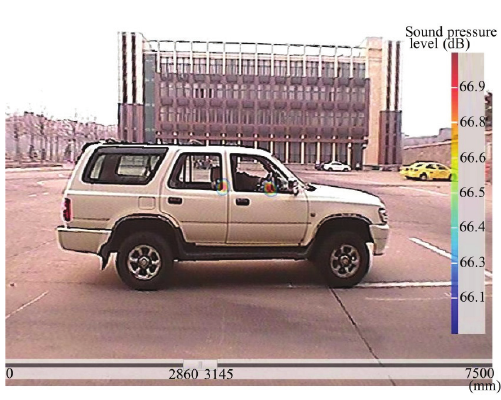
Figure 15: Acoustic map of two closer